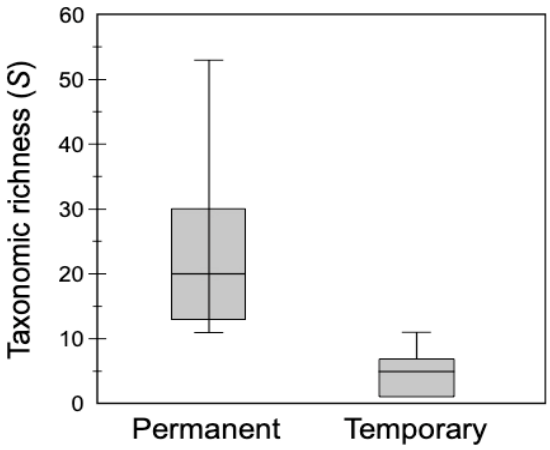
Figure 2. Box plots comparing rotifer taxonomic richness between permanent and temporary waterbodies surveyed in Kenya in 2014 and 2015. Horizontal lines are the median, boxes represent the interquartile range (25–75%), and whiskers represent minimum and maximum values. Lecane bulla was found in all five sampled large lakes (Table 3). Brachionus calyciflorus, Filinia sp., Trichocerca sp., and unidentified bdelloids were found in 60% of large lakes. In small waterbodies, again unidentified bdelloids were most commonly encountered (69.2%). For monogononts, L. bulla was found in 61.5% while B. calyciflorus occurred in 53.9% of them. Two species, B. caudatus and K. tropica , were found only in four of the large lakes, while two species, Lecane papuana and E. dilatata , were found in six and four small waterbodies, respectively, but none of the large lakes. Table 3. Rotifer taxa found in large lakes surveyed in Kenya 2014 ‐ 2015. § see [99].